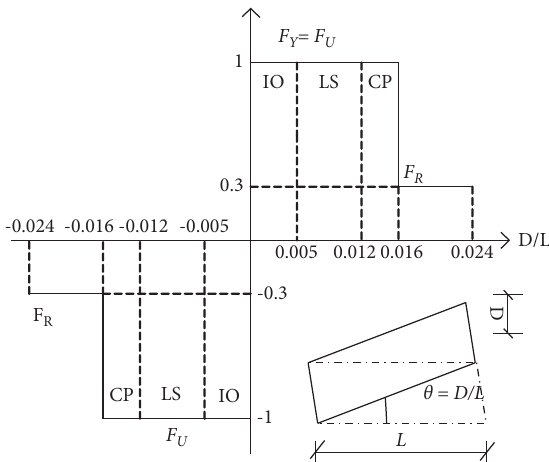
Figure 8: Force-Deformation curve of the component in FEMA 356 and